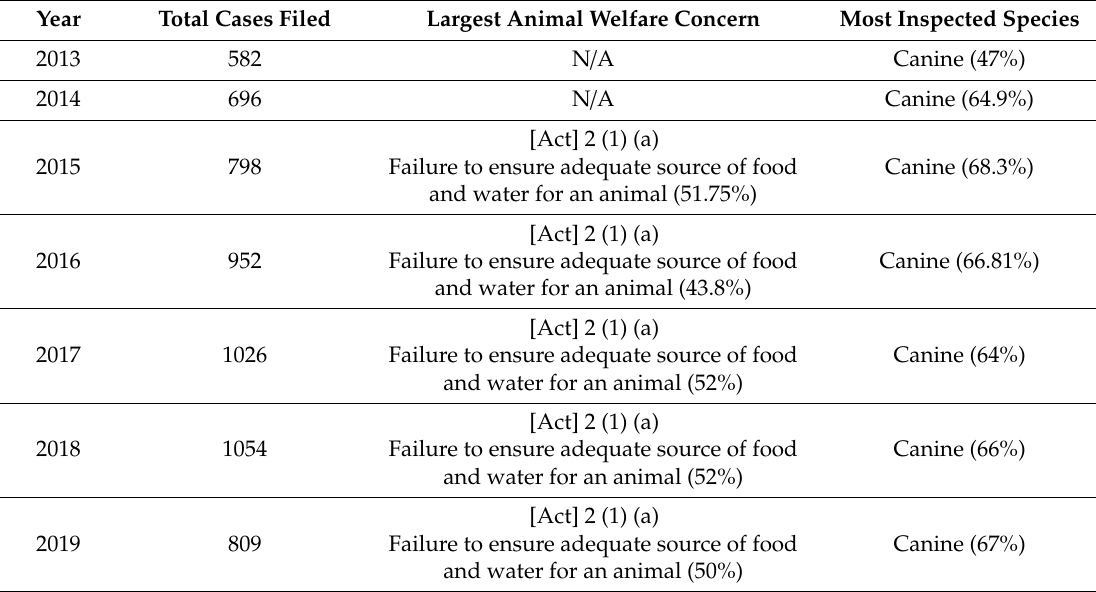
Table 3. Chief Veterinary O ffi ce Animal Cruelty Statistics between 2013 and